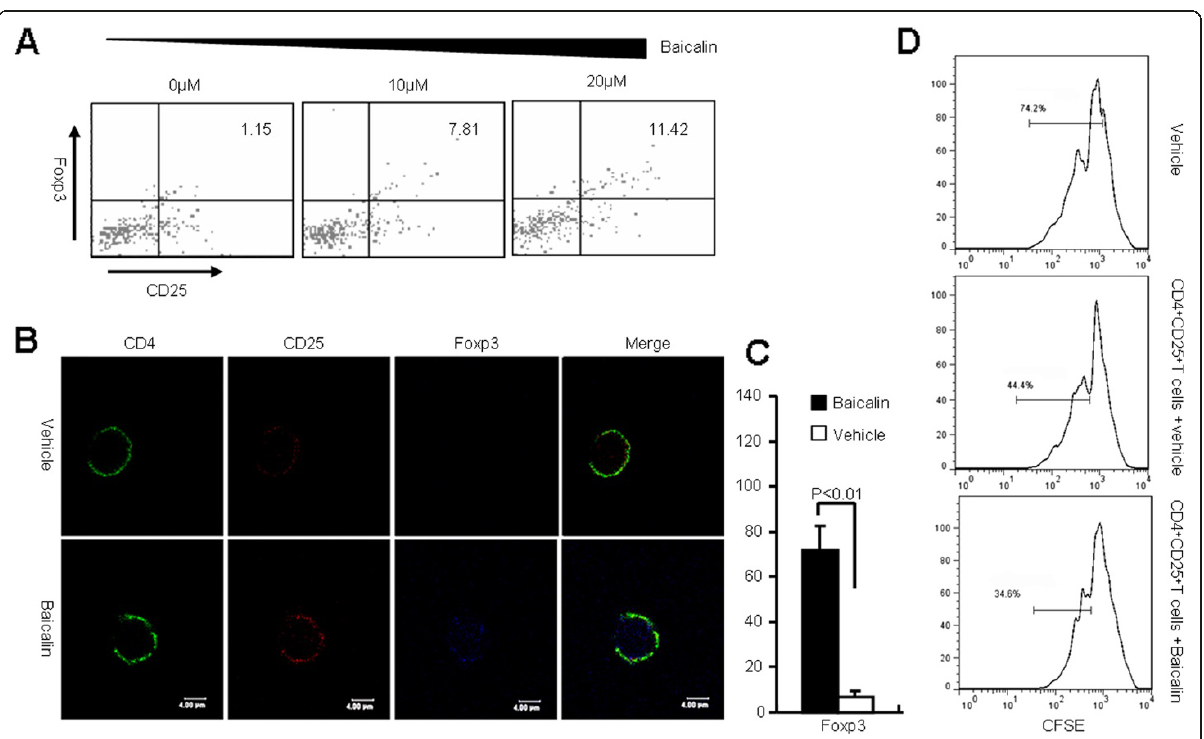
Figure 3 Baicalin up-regulates Foxp3 expression in CD4 + CD25 - T cells. ( A ) FACS-sorted CD4 + CD25 - T cells from B6 mice were stimulated with indicated doses of Baicalin for 3 days. Foxp3 expression in the gate of CD4 + T cells was determined by flow cytometry. ( B ) CD4 + CD25 - T cells from B6 mice were cultured in the presence or absence of Baicalin for 3 days. Using confocal microscopy, nuclear Foxp3 expression was detected in the CD4 + T cells. The scale bar represents 4 μ m. ( C ) Five independent cells were selected randomly from each sample, and shown are results from three independent experiments. ( D ) CFSE labeled CD4 + CD25 - T cells were co-cultured with CD4 + CD25 + T cells at a 2:1 ration in the presence or absence of Baicalin for 5 days, the proliferation of cells was determined by flow